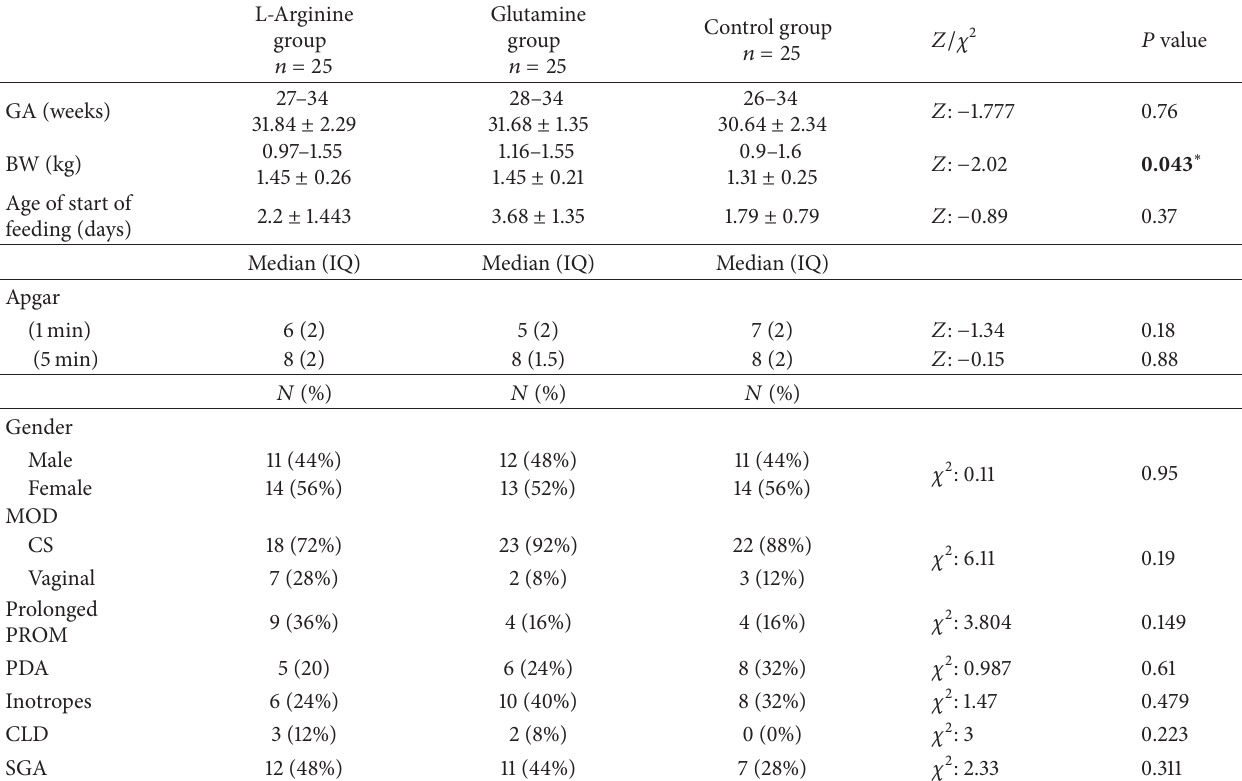
Table 1: Clinical characteristics of the 3 studied